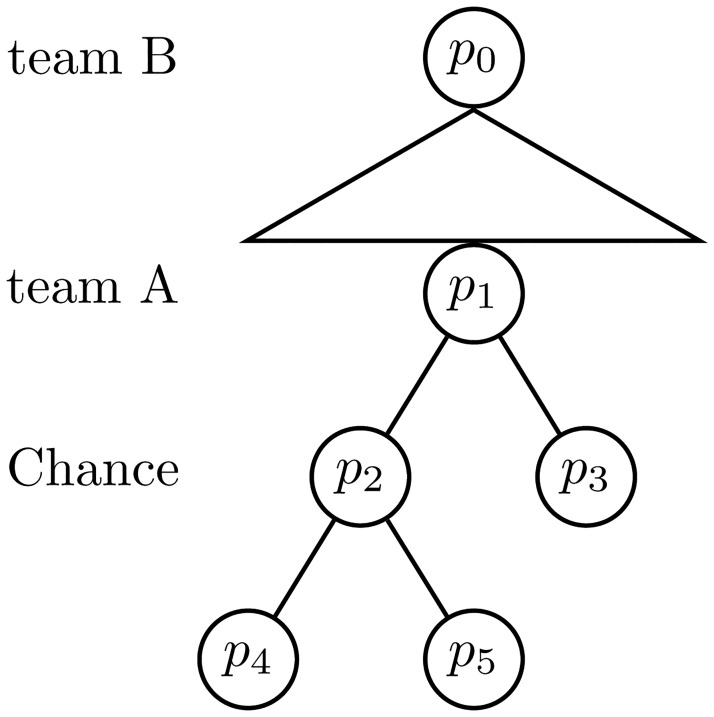
A game tree.An extensive game where p
0 is the starting position, and p
0 (team B), p
1 (team A) and p
2 (chance) are inner positions. Here, team B has a decision in continuum while the team A and chance moves are categorical.